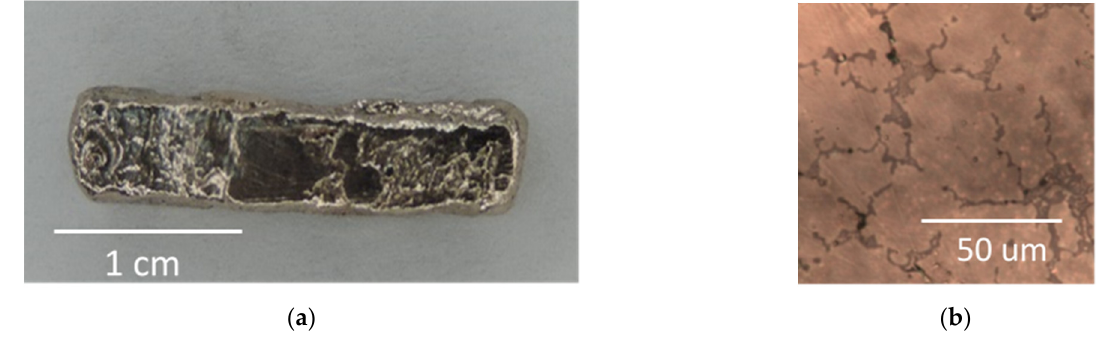
Figure 5. A ~25 mm long metal rod produced from powder (DirectMetal 20 [50]) by the scanned LMH–AM ( a ) and its porous structure ( b ).